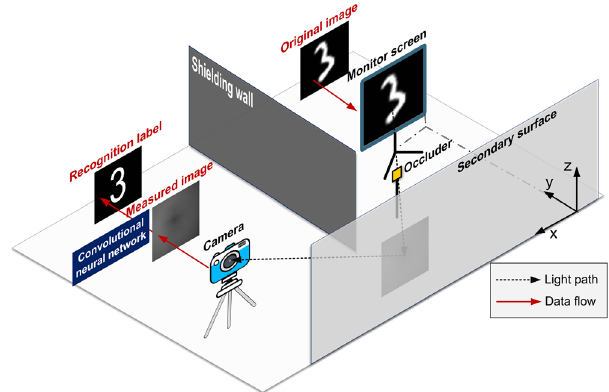
Fig. 1 Schematic of the occluder-based passive non-line-of-sight recognition system. The origin of the x -axis is placed at the lower-right corner of the monitor. The origin of the y - and z -axes is placed at the intersection of the optical table and secondary surface. The position parameters of the screen, occluder, and camera are calibrated using coordinates relative to the origin (0, 0, 0). The black dashed and red solid arrows denote the light path and data fl ow,